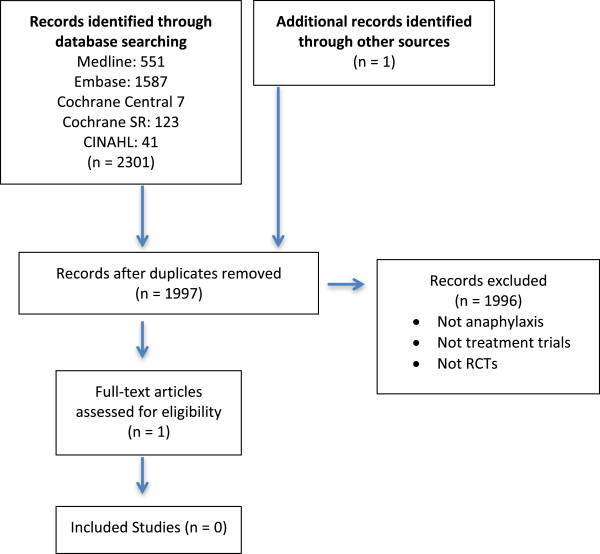
Search flow diagram.